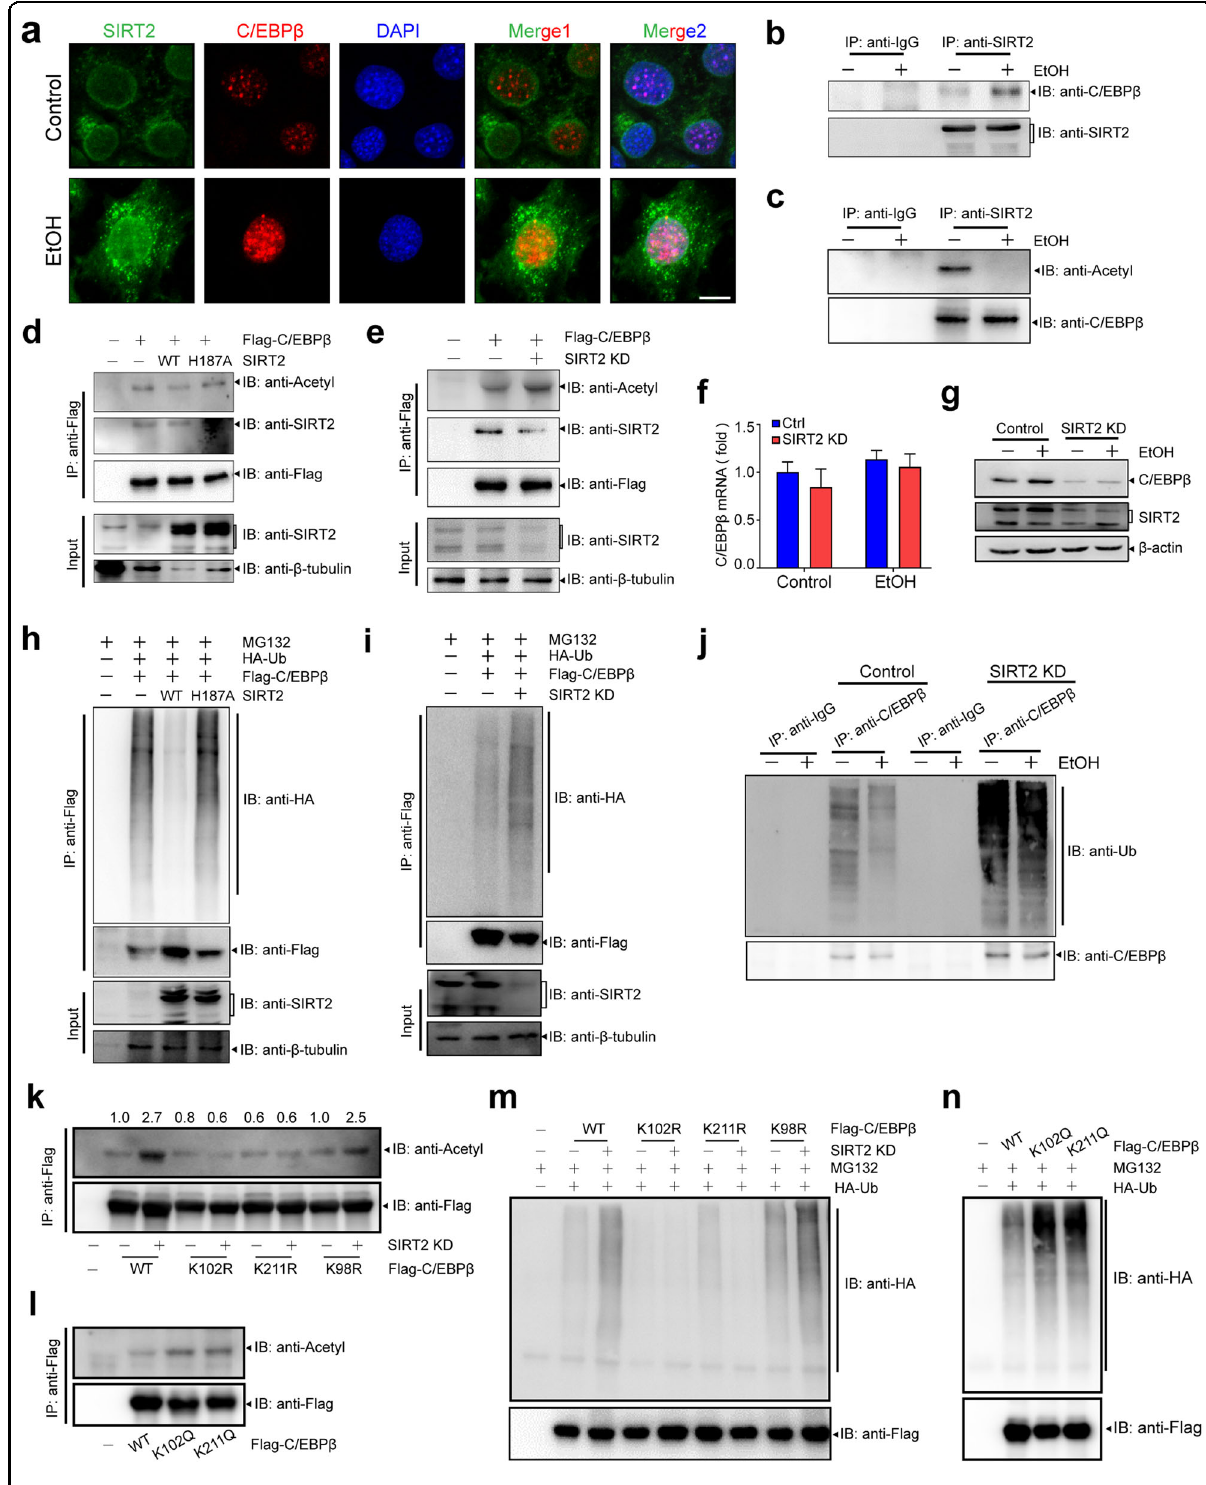
Fig. 6 (See legend on next